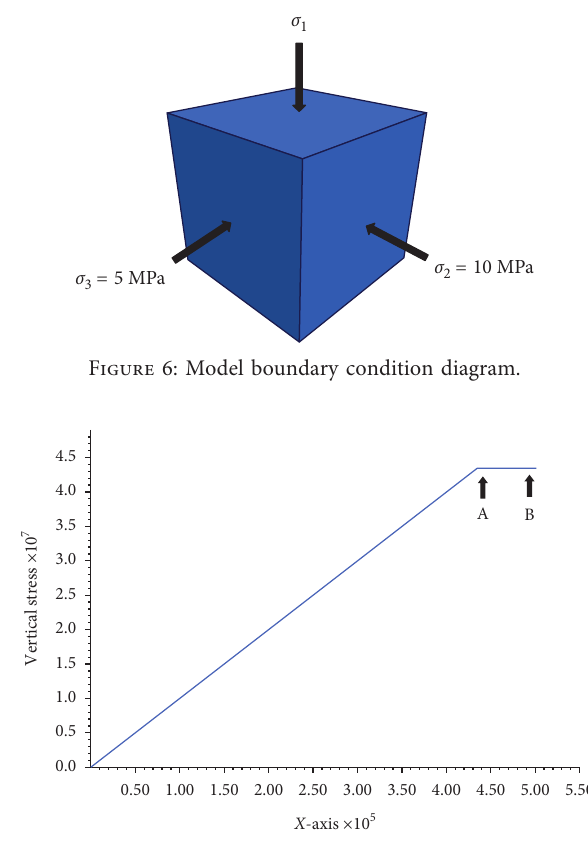
Figure 7: Vertical stress curve of the PMC-2 model.